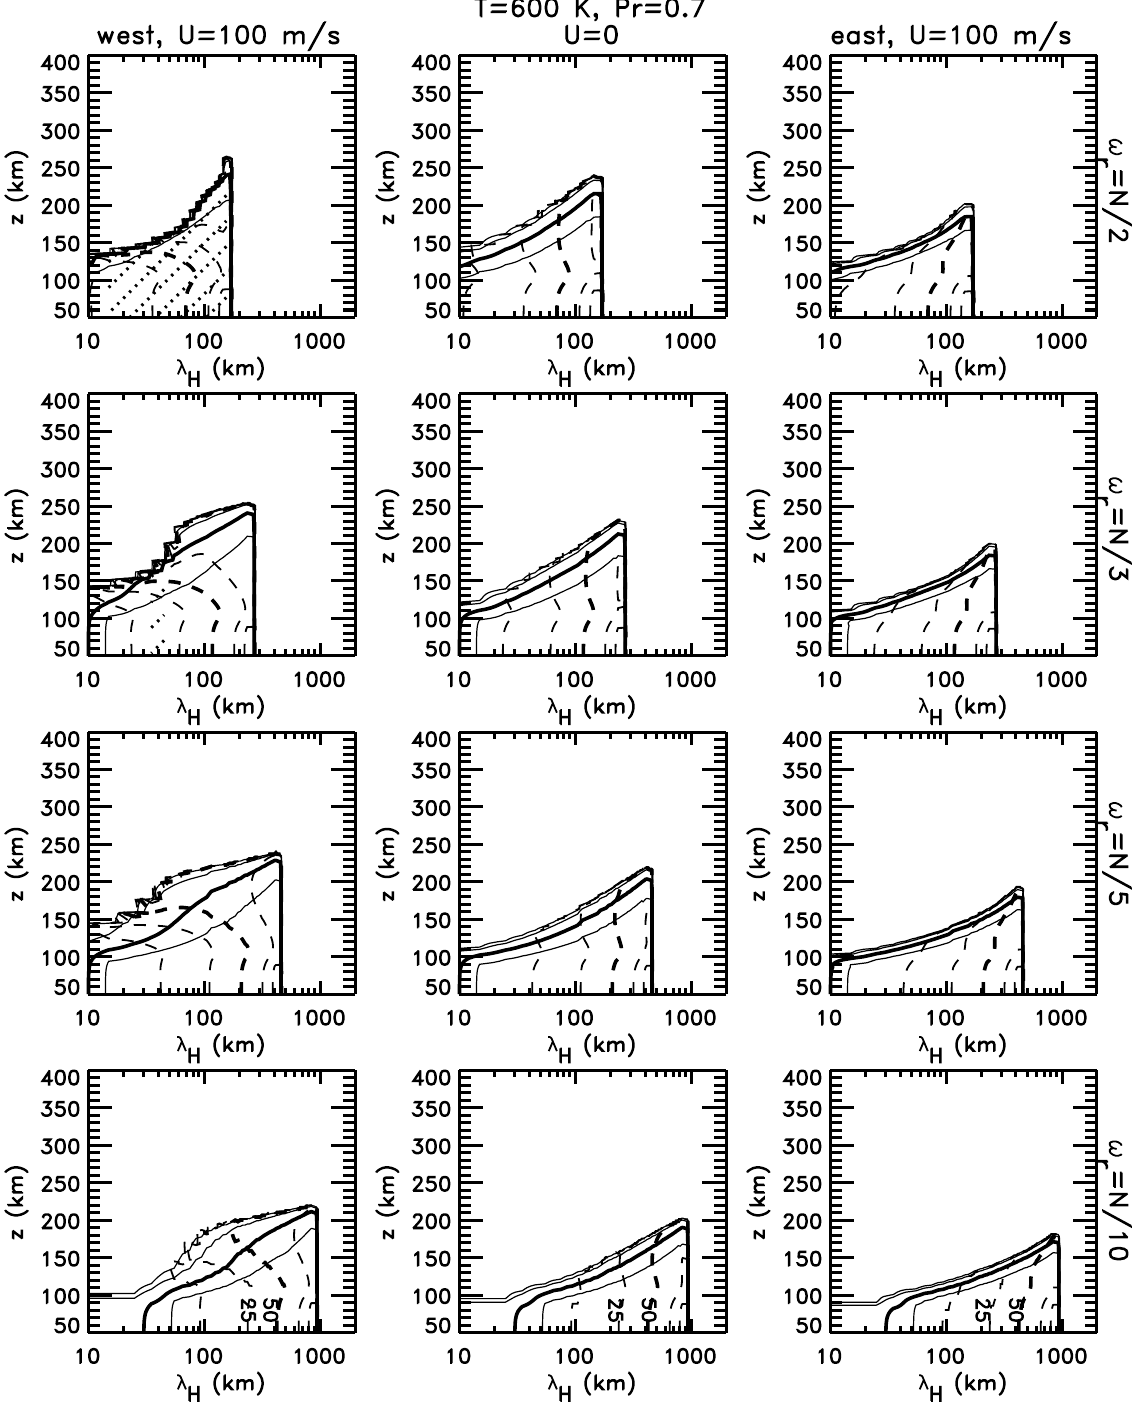
w 0 >) variations with altitude for GWs having horizontal wavelengths varying from Fig. 2. Contour plots of GW momentum flux ( ρ 0 (z)<u 0 h 10 to ∼ 1000km for initial GW frequencies of N/2, N/3, N/5, and N/10 (top to bottom). Left, center, and right panels show results for GWs propagating westward, meridionally (i.e. no wind), and eastward, respectively, in the wind profile shown in Fig. 1c. All GWs were assumed to have unity momentum flux at source levels in the lower atmosphere. Maximum horizontal wavelengths are limited for higher frequencies by the 1/4 H 2 term and the requirement that m 2 in Eq. (1) is sufficiently large to satisfy WKB assumptions. Also shown with dashed lines in each panel are contours of vertical wavelength (in km), with 50km in bold. Momentum flux contour intervals are 0.9, 0.5 (bold), 0.1, and